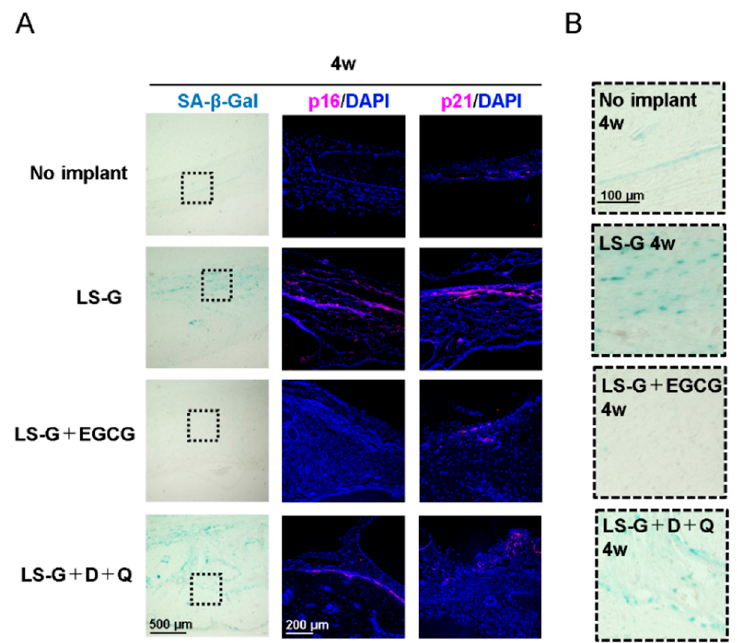
Figure 5. Detection of cellular senescence in bone defects four weeks after surgery. Low ( A ) and high ( B ) magnification microscopic images of bone defects stained with SA- β -gal or antibodies for p16 and p21. Broken lines in ( A ) show magnified area for ( B ). D, Dasatinib; Q, Quercetin; LS-G, implantation of LPS-sustained gelatin sponges in bone defects; LS-G+EGCG, implantation of LS-Gs chemically modified with EGCG in bone defects; LS-G+D+Q, oral administration of D+Q with implantation of LS-Gs in bone defects.